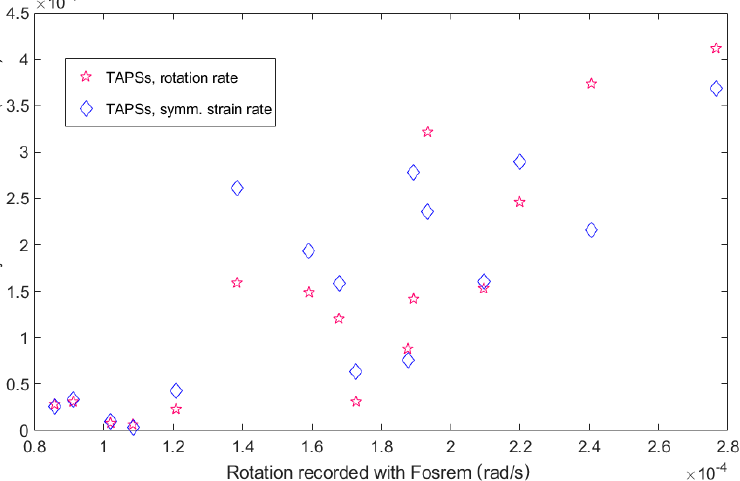
Figure 11. Maximum velocities of the rotation and symmetric strain motions in the rock mass, obtained from two sets of TAPS, were plotted against the maximum velocities of the rotational motions recorded with FOSREM due to the same 16 multiple blasts directed vertically from above. Table 3. Pearson correlation coefficients of the maximal angular velocities and sums of the squares of the angular velocities between all pairs of the sensor datasets.